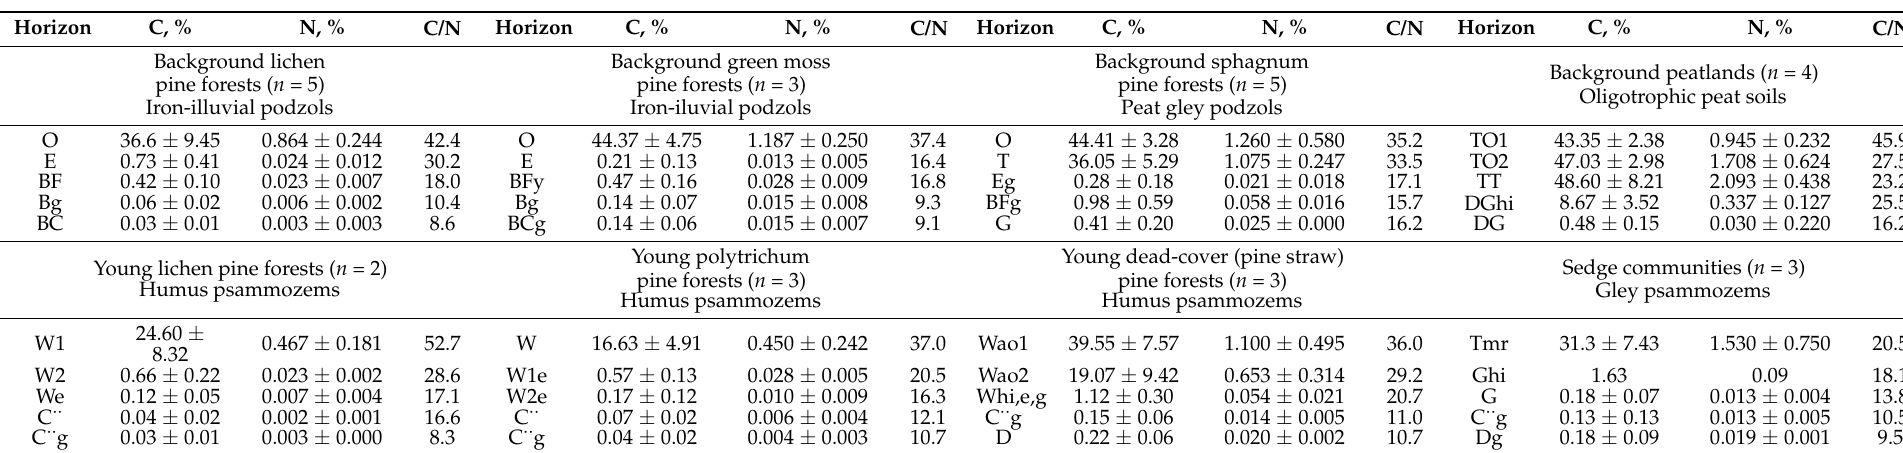
Table 4. The mean content ( X ± σ ) of carbon and nitrogen and the C/N ratio in profiles of the background and young